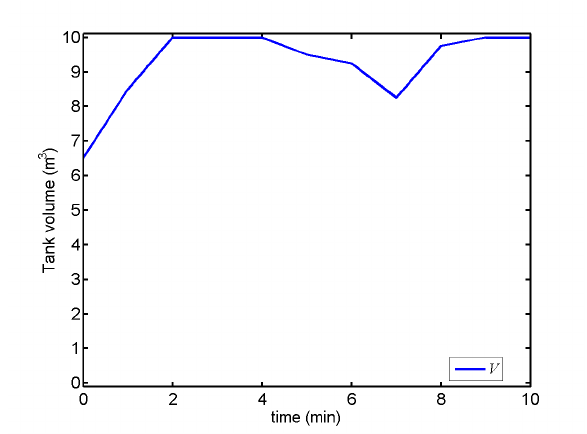
Figure 6. Tank volume with a high limit ( V max ) of 10 m 3 . If the tank volume reaches this limit, overflow may